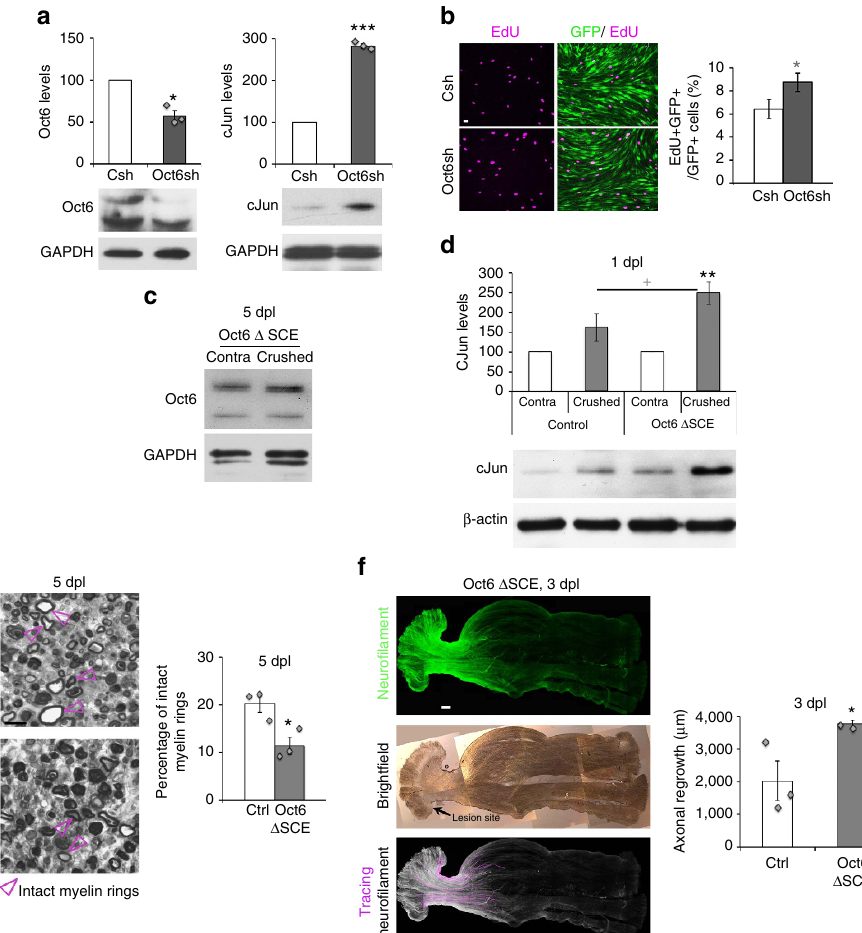
Figure 4 | Decreased Oct6 expression accelerates axonal regrowth. ( a )Western blots of Oct6 and cJun in RSCs transduced with lentiviruses carrying control (Csh ¼ 100) or Oct6 (Oct6sh) shRNAs and quantification normalized to GAPDH showing increased cJun levels in Oct6-downregulated RSCs. Western blot of ( c ) Oct6 in contralateral (contra) and crushed nerves of Oct6 D SCE mice at 5 dpl (representative photos are shown) confirming absence of Oct6 upregulation in this mutant after lesion (as previously reported 12 ), and of ( d ) cJun in crushed and contralateral nerves of adult control and Oct6 D SCE mice at 1 dpl and quantification of protein levels in crushed nerves normalized to b -actin or GAPDH and compared to contralateral nerves ( ¼ 100). ( b ) EdU incorporation identifying increased proliferation in RSCs transduced with lentiviruses carrying Oct6sh compared with Csh. Oct6sh and Csh lentiviruses also carry a GFP reporter showing high transduction efficiency in RSCs. Scale bar, 10 m m. ( e ) Toluidine-blue staining of semithin sections of Oct6 D SCE and control mouse sciatic nerves at 5 dpl and quantification of intact myelin rings (pink arrowheads). Scale bar, 10 m m. ( f ) Z -series projections (confocal stacks) of whole-nerve Neurofilament immunofluorescence in Oct6 D SCE nerves, brightfield showing lesion site and Neurofilament tracings (Scale bar, 300 m m) used for quantification of axonal regrowth (for this graph, the ctrl represented is the same as for graph in Fig. 2c). In Oct6 D SCE nerves, cJun upregulation already occurred at 1 dpl, demyelination at 5 dpl was increased and axonal regrowth at 3 dpl was longer compared with controls, but these effects were less pronounced than in dKO nerves, possibly due to somewhat higher residual levels of Oct6 in the nerves of Oct6 D SCE hypomorph mutant mice compared with dKO nerves. Two-tailed (black asterisks) or one-tailed (grey asterisk and cross) paired ( a ; d : crushed versus contra) or unpaired ( b , e , f ; d : Oct6 D SCE crushed versus control crushed) Student’s t -tests, P values: * P o 0.05 or þ P o 0.05; ** P o 0.01, *** P o 0.001. Values, mean; error bars, s.e.m. In d , asterisk shows significance compared with contra and the cross compared with control. Sample size: ( a ) n ¼ 3, ( b ) n ¼ 9, ( c ) 3 animals per group, ( d ) 6 animals per group, ( e ) 3 animals per group, 227 to 435 myelin rings counted per animal. ( f ) 3 animals per group, 10 to 25 tracings per nerve. during postnatal development 18 . We thus hypothesized that and the Krox20 MSE was respectively fully and partly dependent Sox10 coordinates the activation of the Oct6 SCE and Krox20 on HDAC1/2 activity (Fig. 7c,d). MSE after lesion with HDAC2-, JMJD2C- and KDM3A-mediated de-repression of these targets. Indeed, Sox10 recruitment to the Oct6 SCE HR2 and Krox20 MSE was increased at 1 and 12 dpl, Protein complex activating Sox10 target genes after lesion . respectively, compared with unlesioned nerves (Fig. 7a,b). Consistent with HDAC1/2 known functions on histones, we In RSCs cultured under dedifferentiating conditions, Sox10 found increased levels of acetylated histone H3 in dKO nerves at overexpression increased the D HR1, but decreased the D HR2 the Oct6 SCE HR2 at 1 dpl and at the Krox20 MSE at 12 dpl Oct6 SCE activation (Fig. 7c), suggesting HR1 repression and (Supplementary Fig. 13a,b), despite impaired Oct6 and Krox20 HR2 activation by Sox10 during dedifferentiation. Sox10 also transcription. This indicates that histone acetylation or increased Krox20 MSE activation in redifferentiating conditions hyperacetylation in gene enhancers does not always correlate (Fig. 7d). Sox10-induced activation of the HR2 ( D HR1 construct) with transcriptional activation and supports the hypothesis that NATURE COMMUNICATIONS|8:14272|DOI: